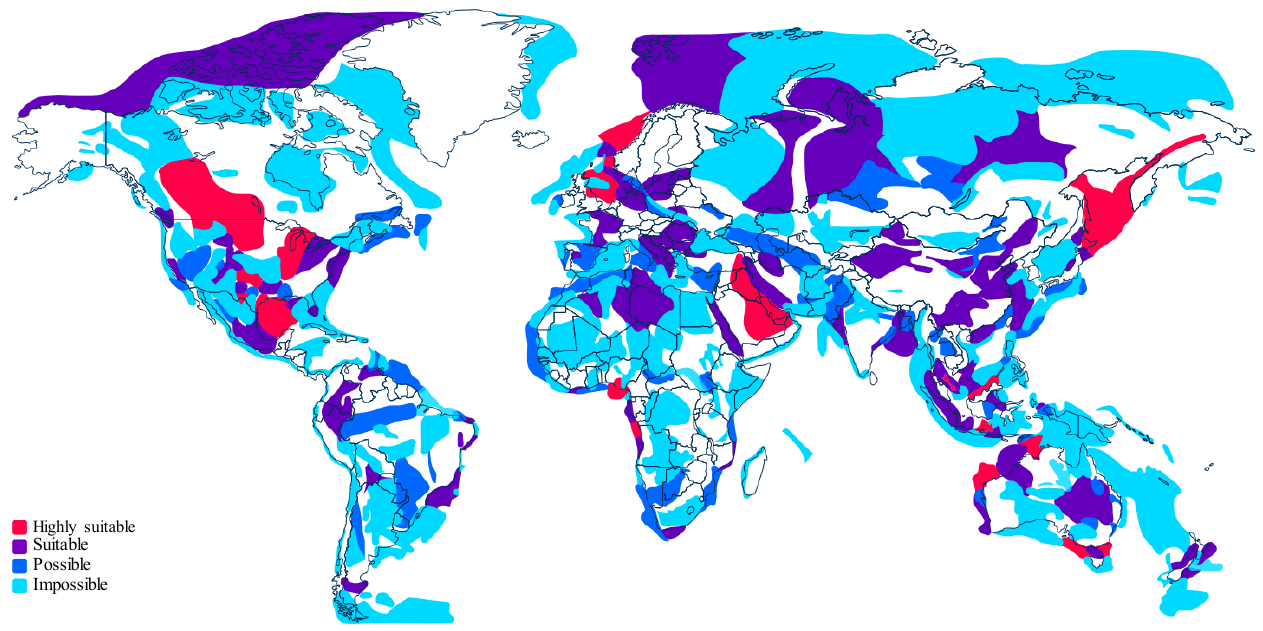
Figure 2. Distribution map of suitable storage areas in the world [3].